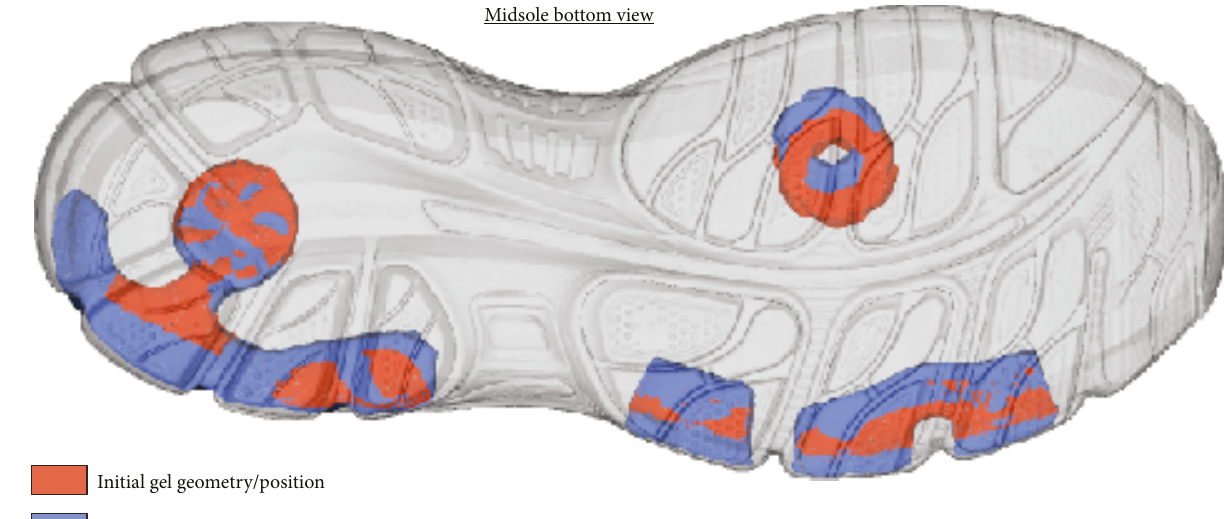
Figure 8: Initial and optimal gel pads (superimposed on the midsole